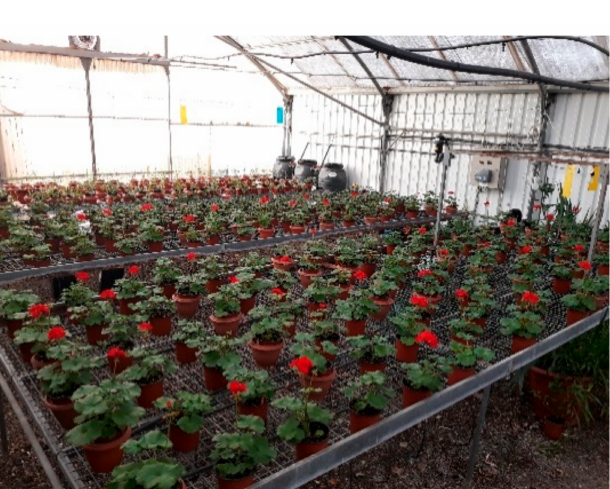
Figure 2. Pelargonium hortorum plants cultivated in the greenhouse, under the di ff erent treatments